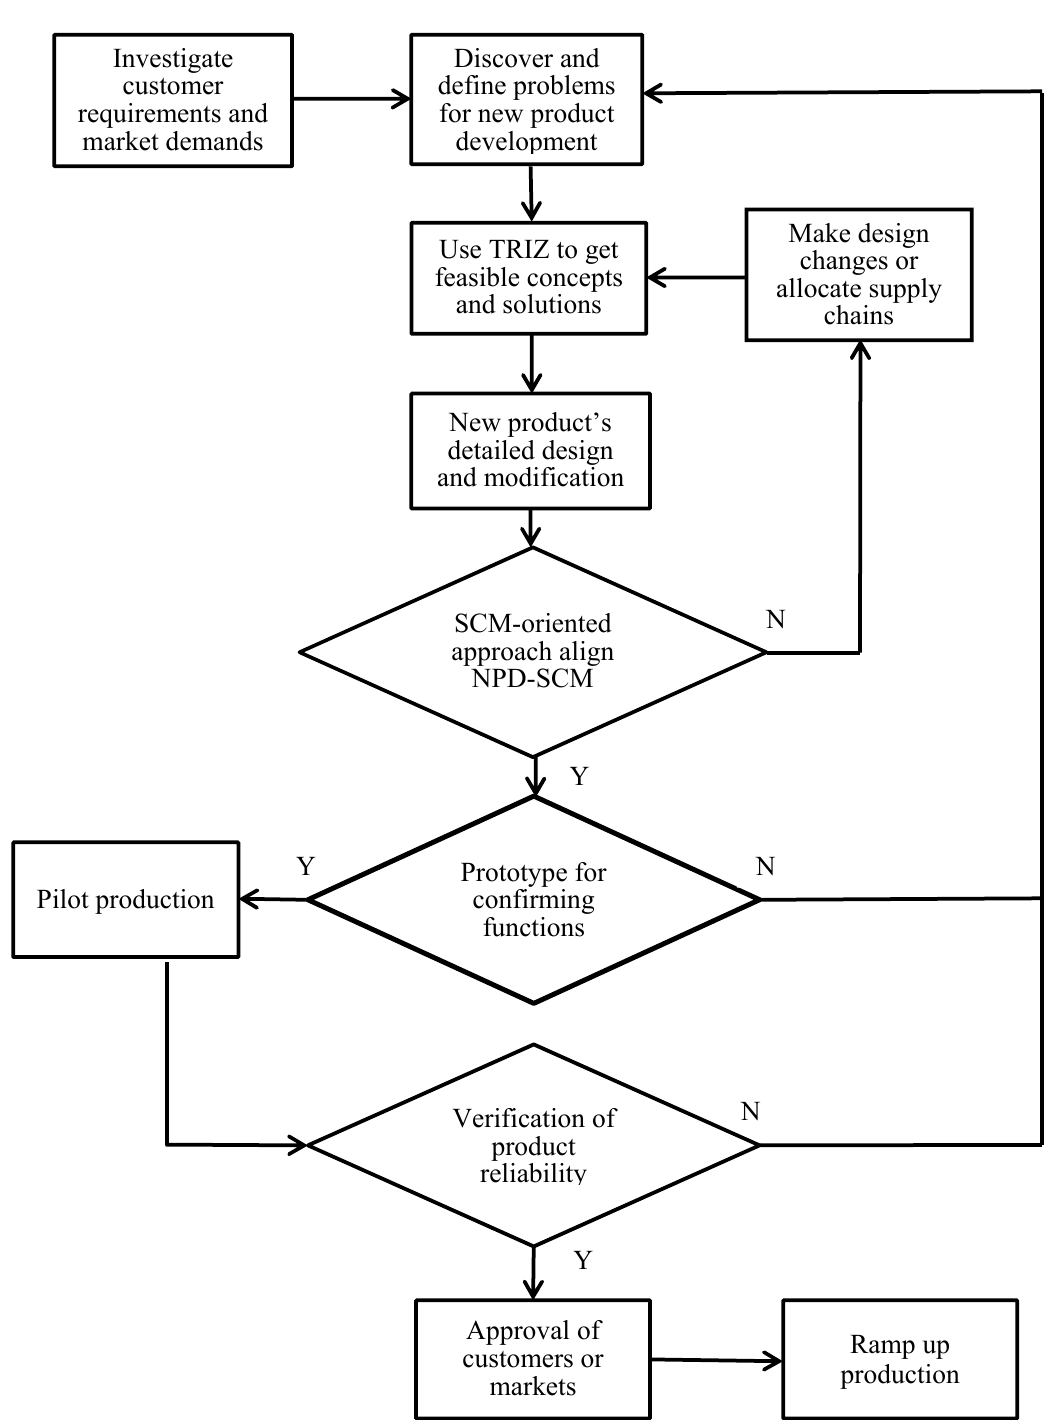
Figure 3. The investigated company’s NPD process based on the TRIZ and NPD-SCM alignment.